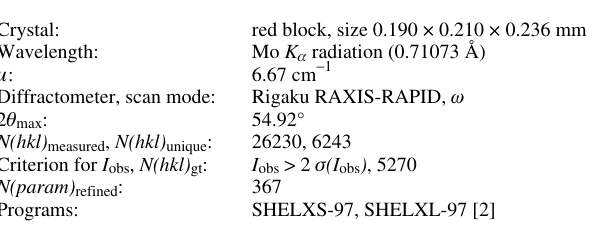
Table 1. Data collection and handling.